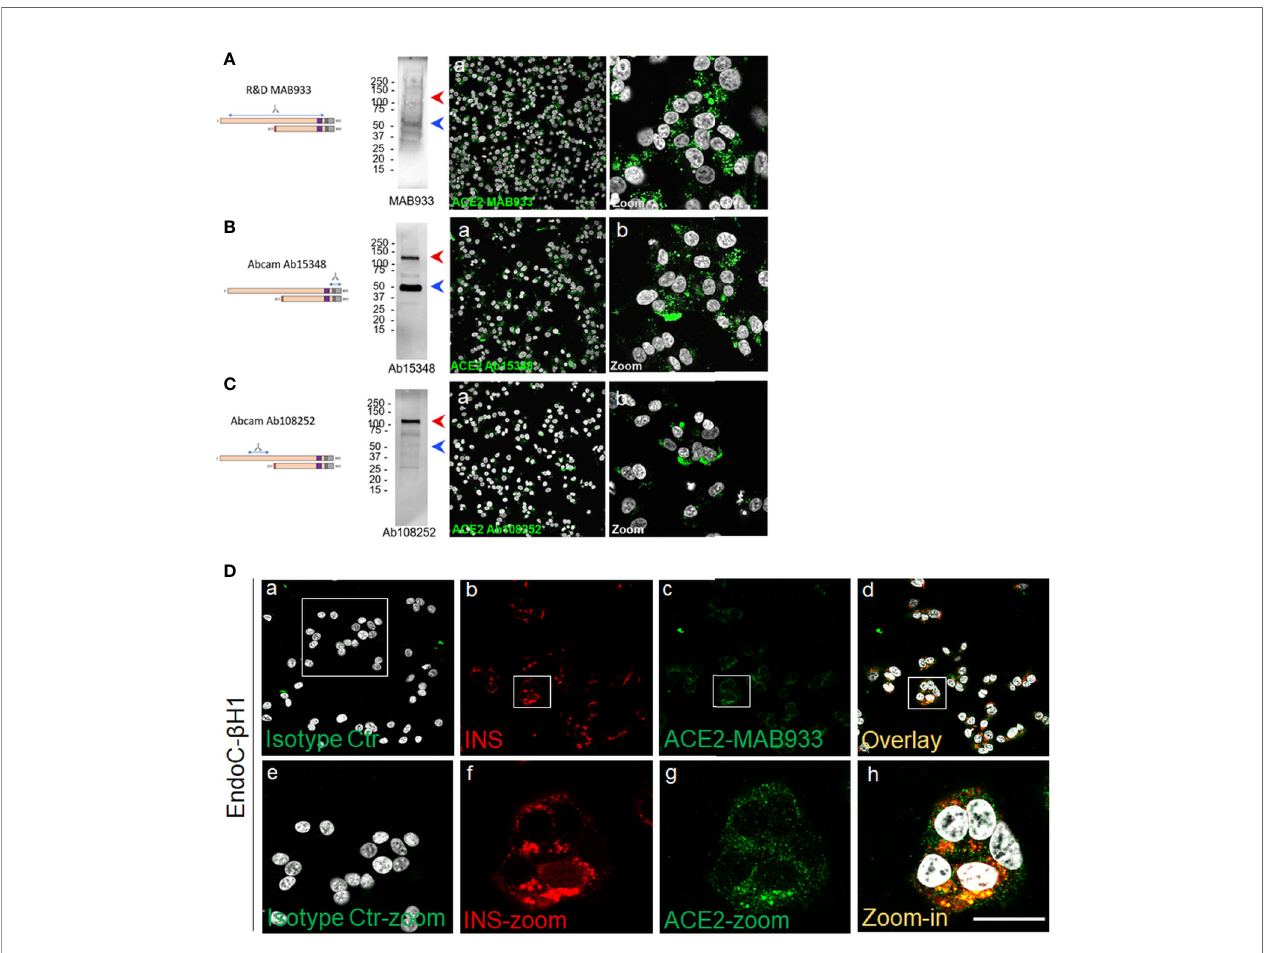
FIGURE 5 | A short-ACE2 isoform isprevalentlyexpressed in human b -cellline EndoC- b H1. Western Blot andImmuno fl uorescence analysis of EndoC- b H1 using (A) R&D monoclonal MAB933, (B) Abcam polyclonal Ab15348 and (C) Abcam monoclonalAb108252 anti-ACE2 antibody. Foreach antibody adopted,speci fi c target sequence is reported within the aligned ACE2 isoforms. In westernblot analysis, molecular weight markers(from15 kDa to 250 kDa) are reported; red arrows indicate long-ACE2 isoform (expected bandof~110kDa),while blue arrows indicate short-ACE2 isoform (~50kDa). (D) ACE2 (R&D MAB933)and insulin doubleimmuno fl uorescence analysis inEndoC- b H1 cultured cells. Negative isotype primary antibody control (relative to ACE2 primary antibody) isshown inpanel-a. Insulin(red) andACE2 (green)are reported inpanels-b and-c, while overlay isreportedin panel-d. Digitalzoom-in images arereported from panels-e to -h.Scalebar inpanel-h = 15